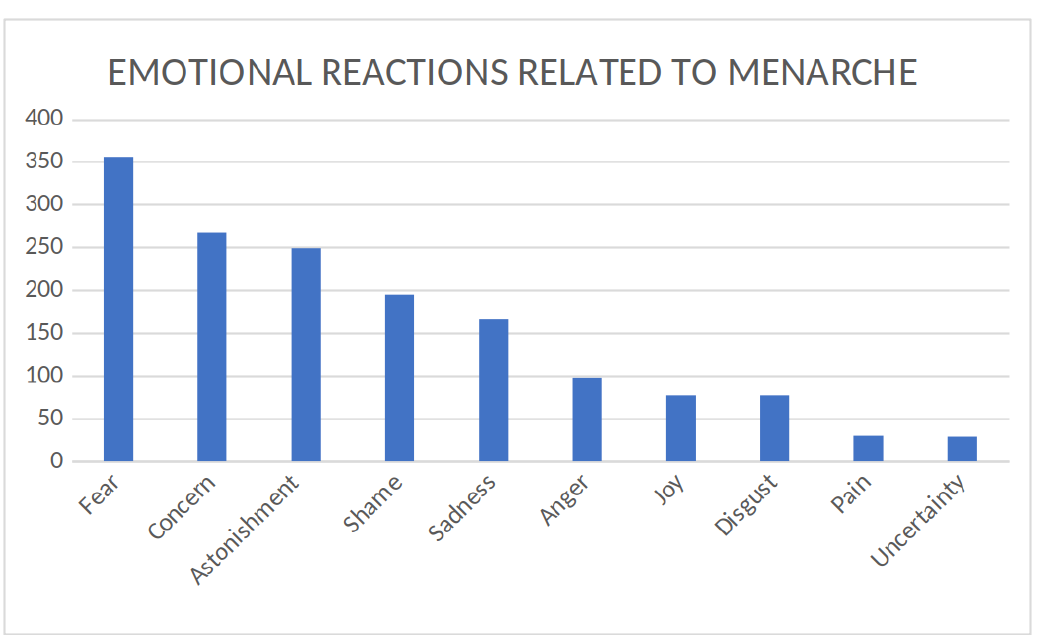
Figure 3 – Source: Own